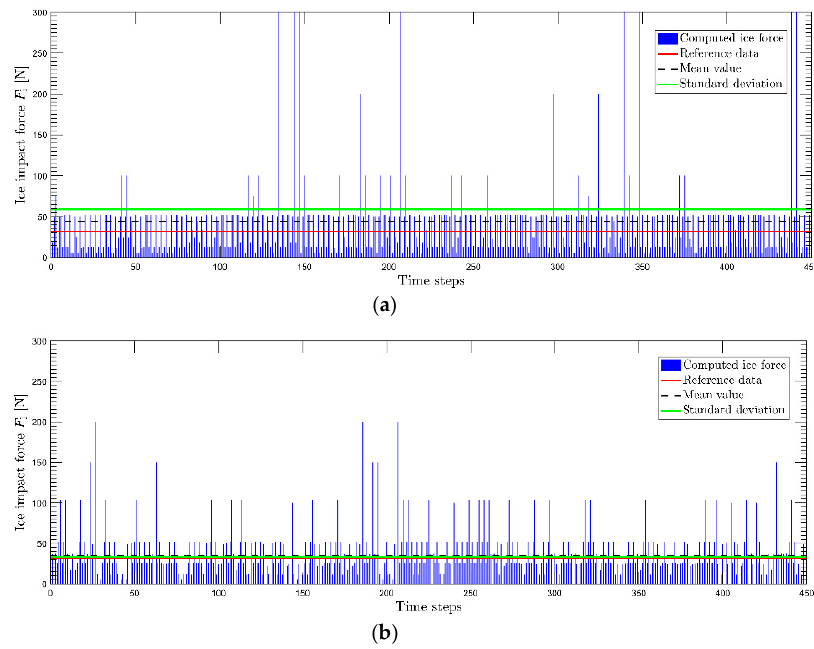
Table 4. Ice force result summary and comparison.